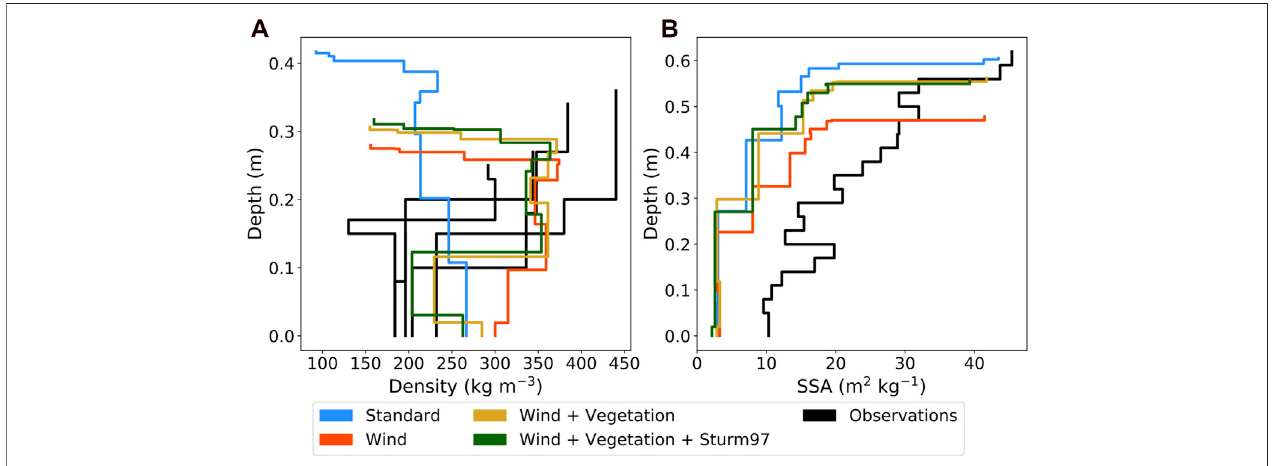
FIGURE3| Verticalpro fi lesofsnowdensityatCambridgeBay,onMay10,2017 (A) ,andofSSAatTrailValleyCreek,onMarch22,2018 (B) .Observed(black)and simulated with standard parametrizations of Crocus (blue), Wind parametrization (orange), Wind and Vegetation parametrizations (yellow) and Wind, Vegetation and Sturm97 parametrizations (green) (see Table 3 for parametrization de fi nition, and Table 1 for data and site references).